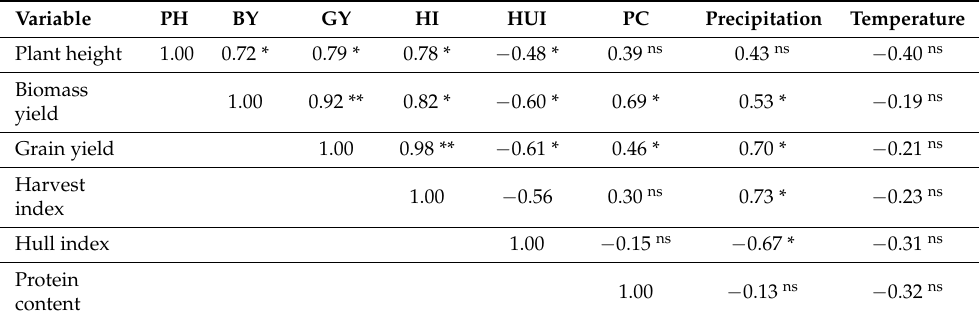
Table 5. The correlation coefficient of the examined traits. Variable PH